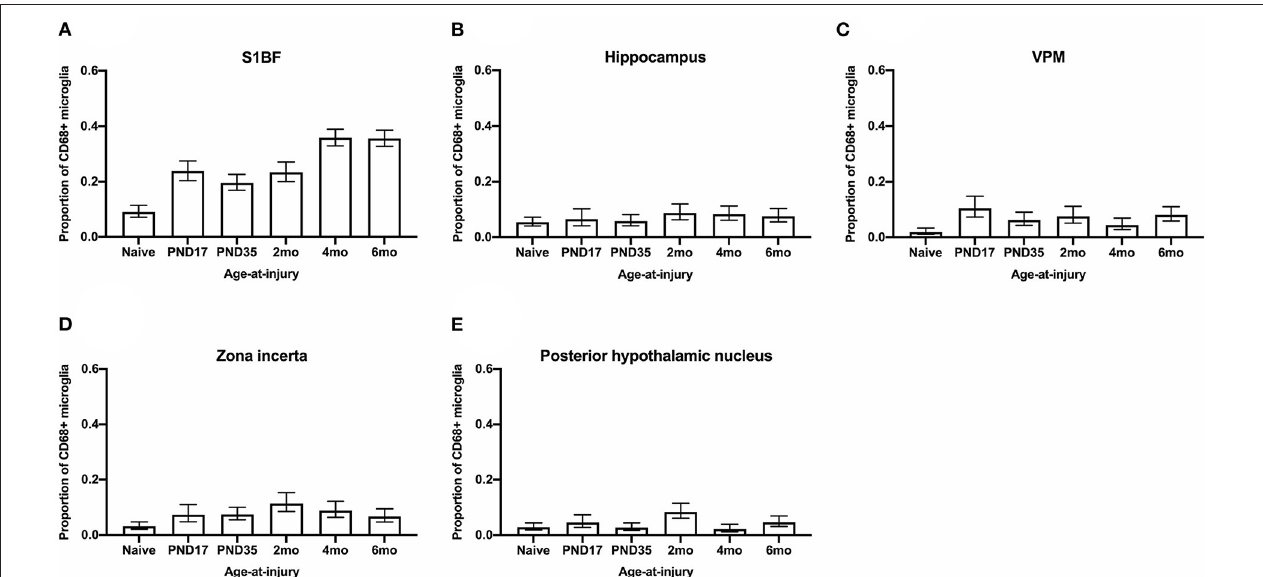
FIGURE 8 | The proportion of microglia colocalized with CD68 were quantified in the S1BF, hippocampus, VPM, zona incerta, and posterior hypothalamic nucleus. Microglial colocalization with CD68 is expressed as the proportion of CD68 + microglia (mean ± 95%CI) in the primary sensory barrel field (S1BF), hippocampus, ventral posteromedial nucleus (VPM), zona incerta, and posterior hypothalamic nucleus. Significantly more CD68 + microglia were observed following mFPI compared to naïves in the S1BF (A) , zona incerta (C) , and VPM (D) regardless of whether the TBI was recent or remote. However, in the hippocampus (B) and posterior hypothalamic nucleus (E) , a greater proportion of microglia colocalized with CD68 was only evident compared with naïves with a more recent TBI (see Table 5 ). colocalize with CD68 puncta ( Figure 7D ). Rod microglia, shown for the S1BF, aligned perpendicular to the dural surface ( Figure 7E ). Microglia colocalized with CD68 were quantified as the proportion of CD68 + microglia in relation to the total number of microglia counted in the four images taken of the S1BF, hippocampus, VPM, zona incerta, and posterior hypothalamic nucleus ( Figures 8A–E ). Brain-injured groups had significantly greater proportion of CD68 + microglia than naïve = 67.4; p < 0.001), but the proportion of CD68 + microglia ( χ 2 5 = in age-at-injury groups varied significantly by region ( χ 2 20 106.1; p < 0.001) (see Supplementary Table 7 for estimated counts and 95% CIs; Figures 8A–E ). In the S1BF, VPM, and